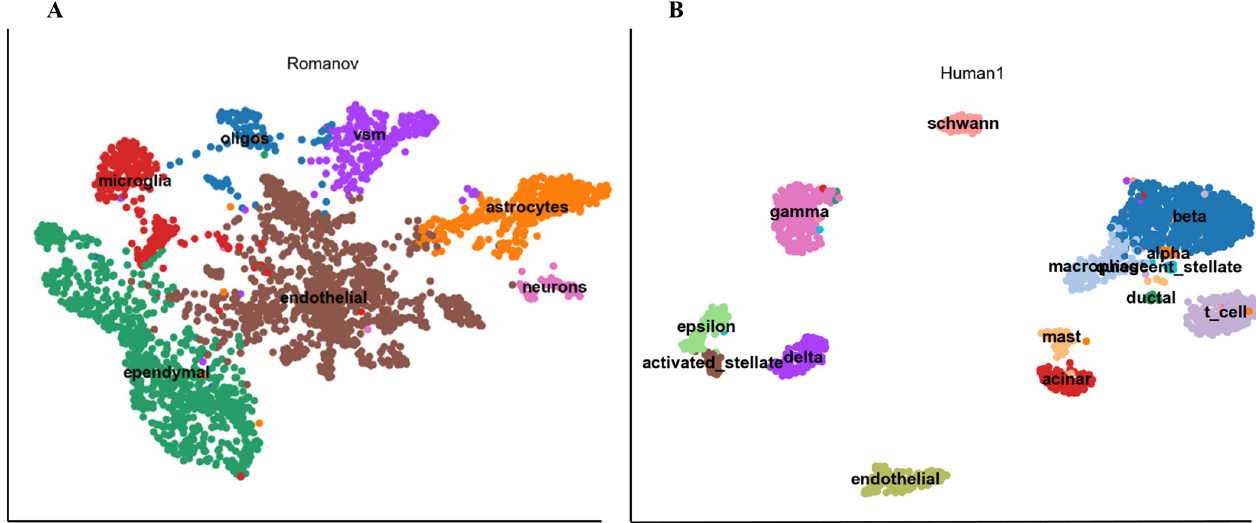
Fig 3. The results of cell visualization and annotation. We have given the real cell types on the visualization results, which can help us more intuitively obtain the biological information contained in scRNA-seq datasets. In the figure, we can clearly see the location relationship and distribution between different types of cells. Left A is the visualization result of Romanov dataset, which has 7 cell types. And B represents the results of Human1 dataset, which has 14 cell